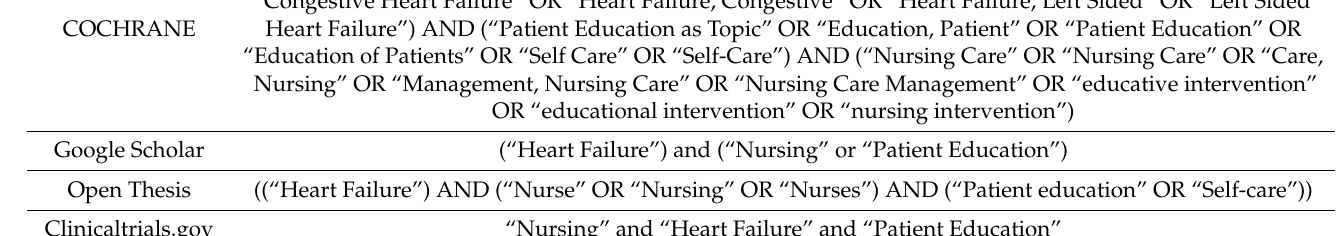
Table A2. Risk of bias assessment.